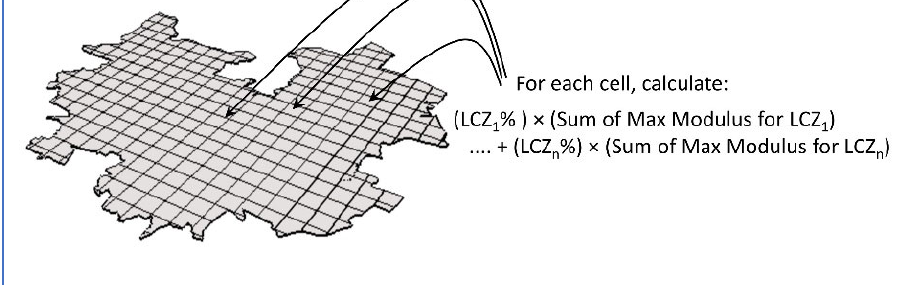
Table 4. Criteria and number of